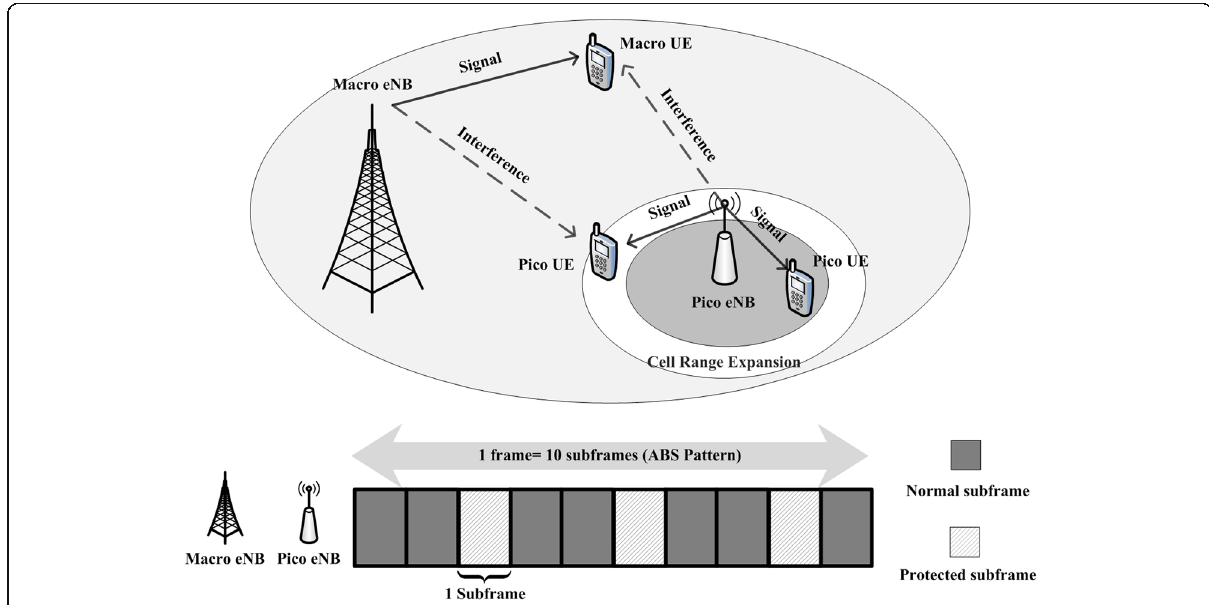
Fig. 1 Heterogeneous network with inter-cell interference and cell range